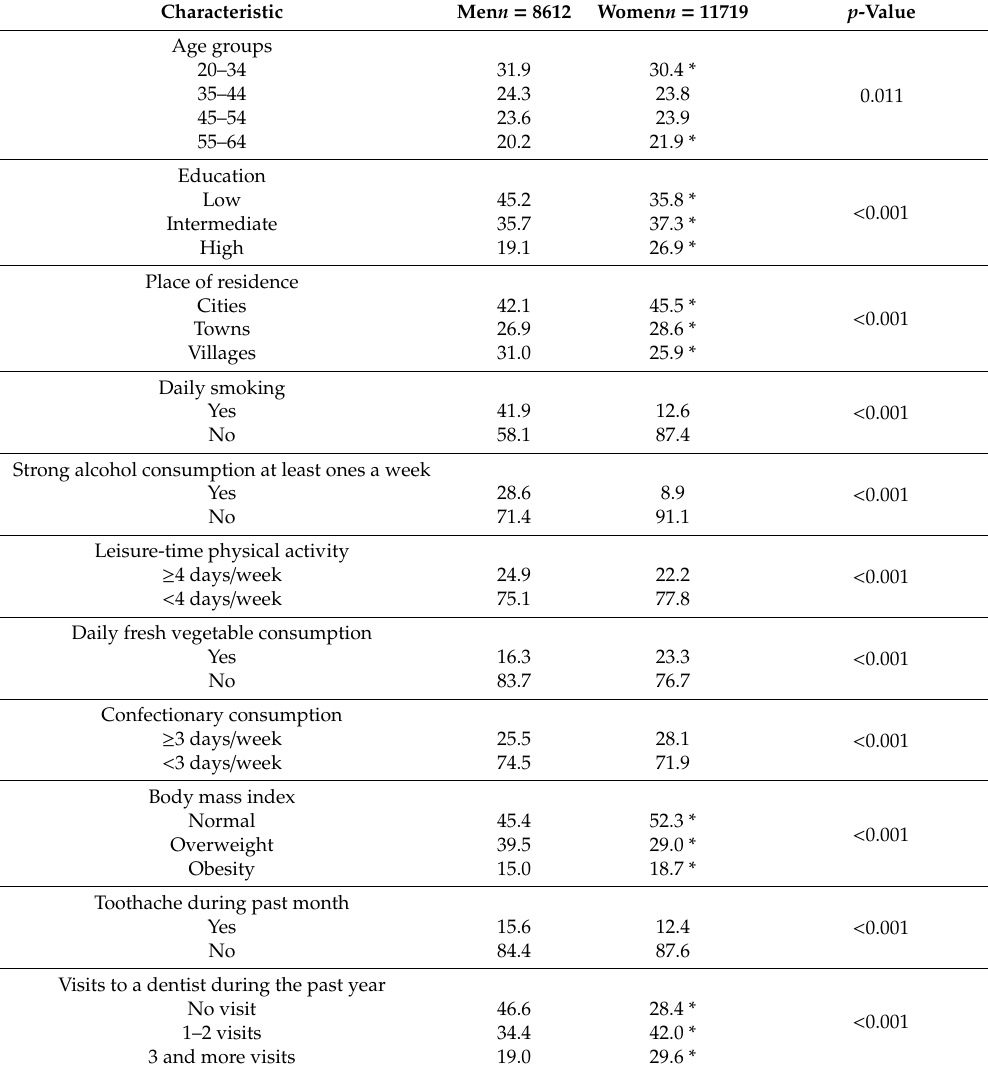
Table 2. Characteristics of the study population